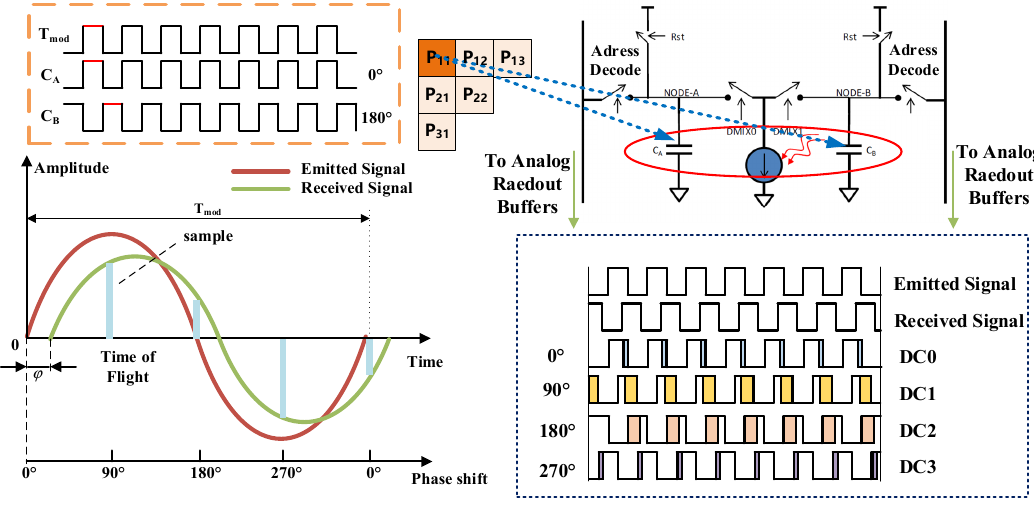
Figure 2. Signal demodulation method.